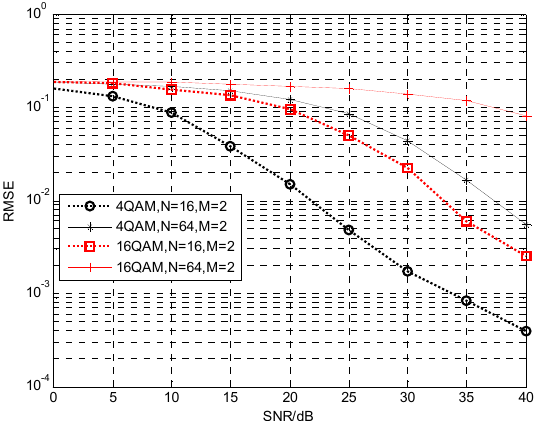
Figure 5. RMSE performance of subspace blind method for different modulation and different number of N , with M = 2, N s =